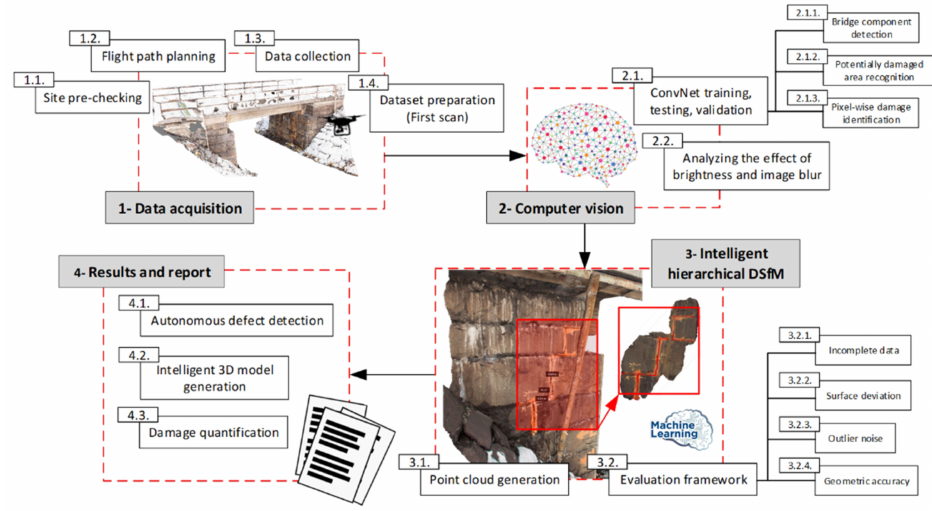
Figure 3. The schematic workflow of the proposed intelligent hierarchical structure from